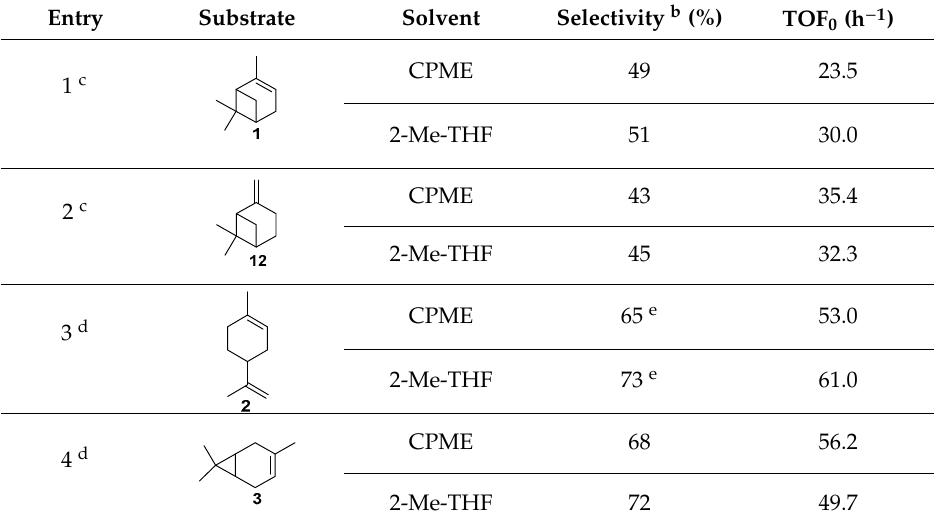
Table 12. Epoxidation of terpenes, catalyzed by [C12] 3 [PW 12 O 40 ] nanoparticles in CPME or 2-Me-THF a (adapted from reference [49]).